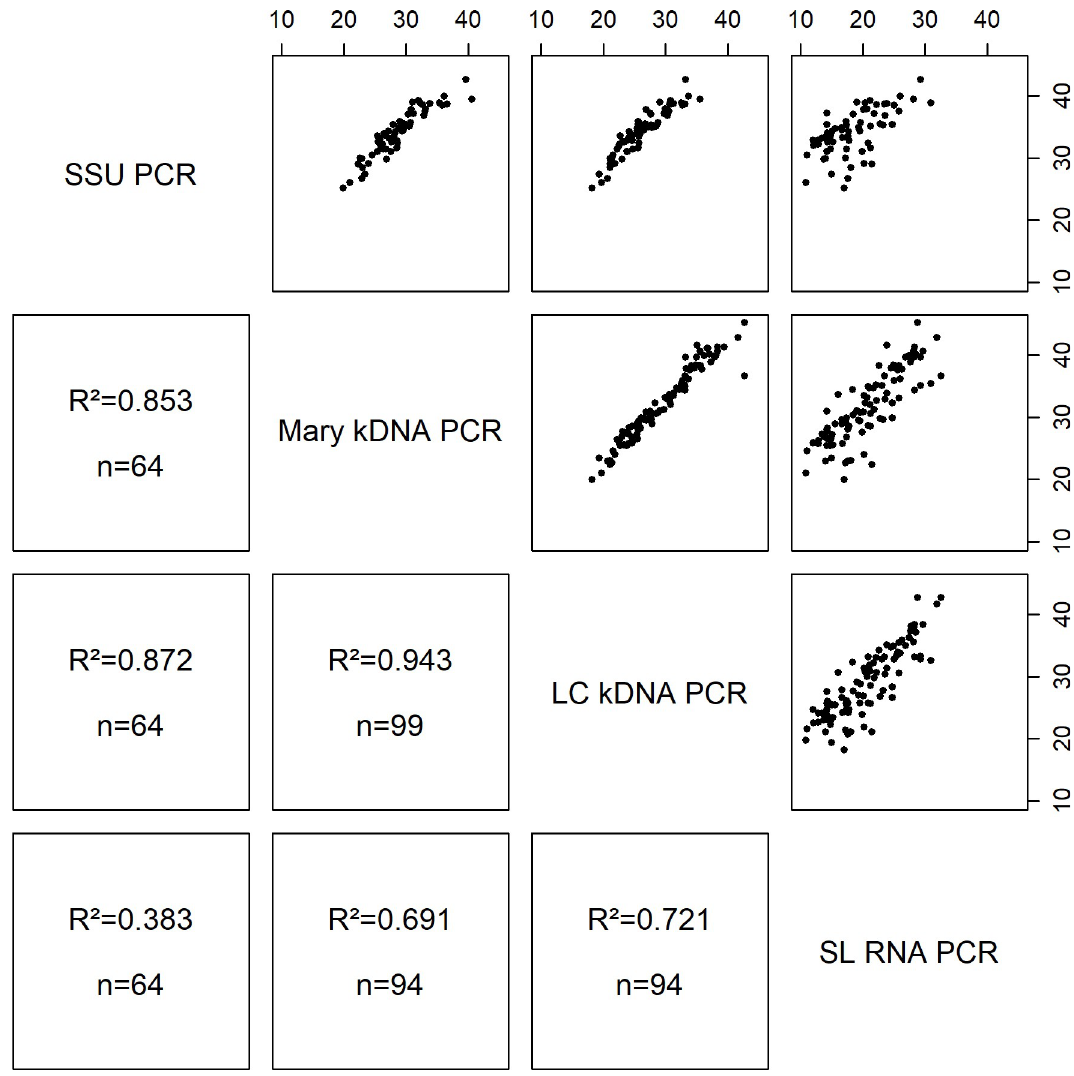
Fig 2. Comparison of Ct-values for the different real-time PCR assays on positive skin scraping DNA and RNA extracts. R 2 : squared correlation; n: number of samples positive in both PCR methods that were compared. The Ct-values are displayed on the X- and